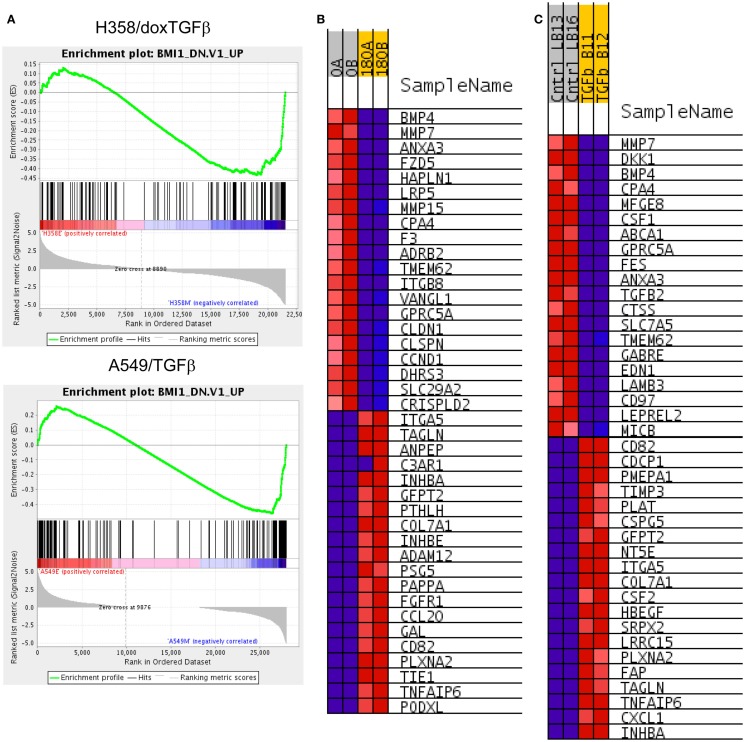
(A) Increased BMI target gene enrichment from RNA-Seq datasets comparing differential RNA expression between H358 and A549 cell states. Statistical significance (p < 0.0001 and FDR q-value <0.04 was observed. (B) The top 20 positively and negatively correlated genes were identified and heat mapped for H358 and (C) for A549, with labels as defined in Figure 3.